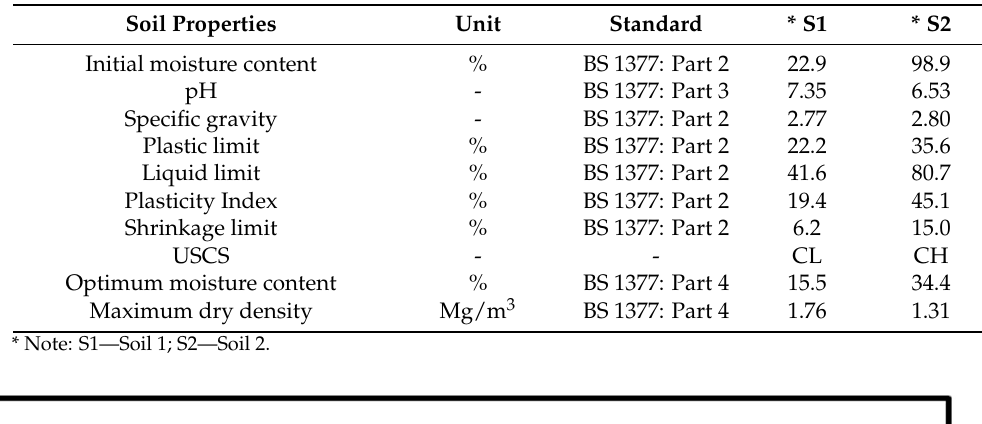
Table 1. Geotechnical characteristics of untreated soils.